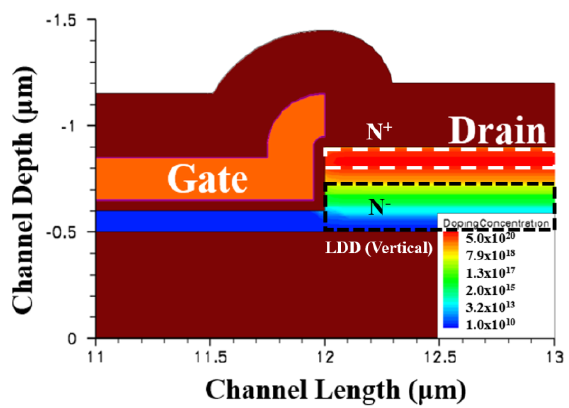
Figure 3. The simulated drain region doping concentration of a type-A RSD structure.